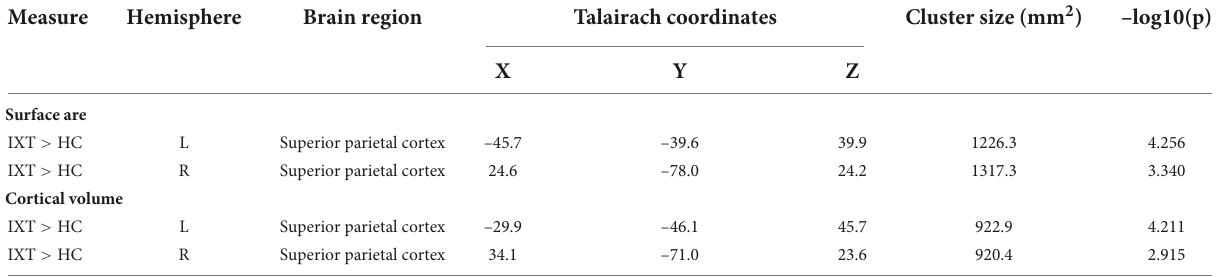
TABLE 3 Brain regions with altered age-related cortical morphometric measures in IXT compared to HC. Measure Hemisphere